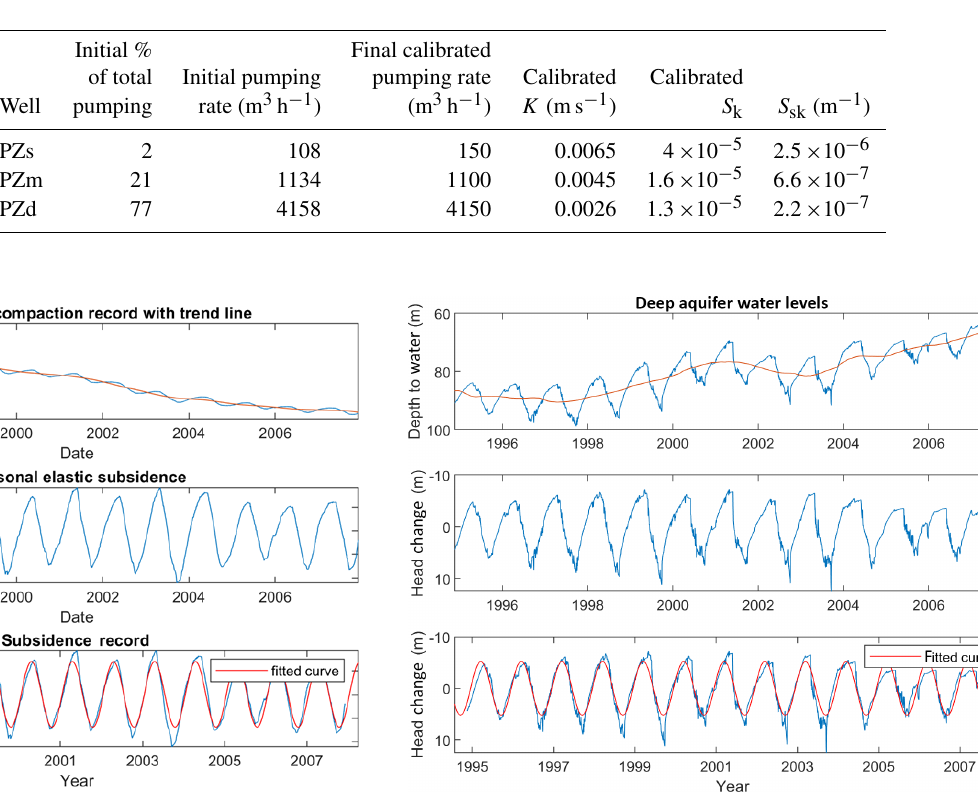
Figure 4. (a) Long-term deep piezometer record (blue) with trend line (orange), (b) seasonal water levels with trend removed and (c) seasonal water levels (blue) with fitted sine function (orange) revealing mean frequency and amplitude of water levels in the shal- low